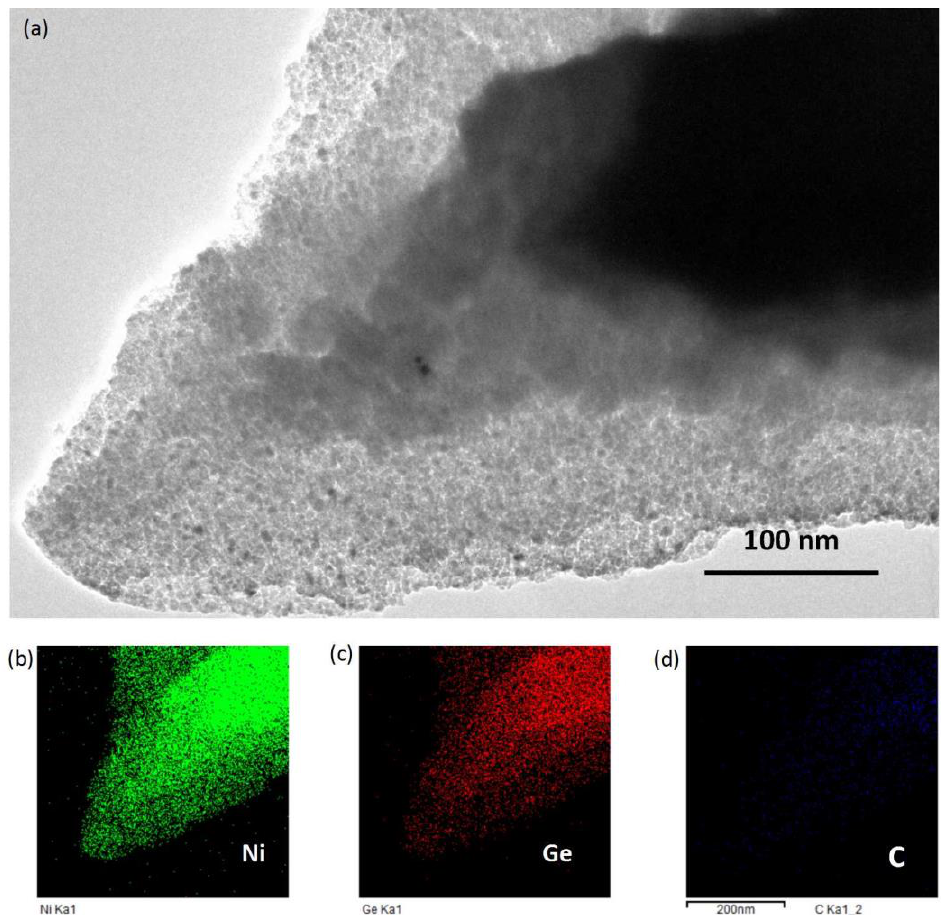
Figure 7. TEM images: ( a ) the Ge composite film growing on the graphite, ( b ) the nickel element distribution map, ( c ) the Ge element distribution map, and ( d ) the carbon element distribution map.